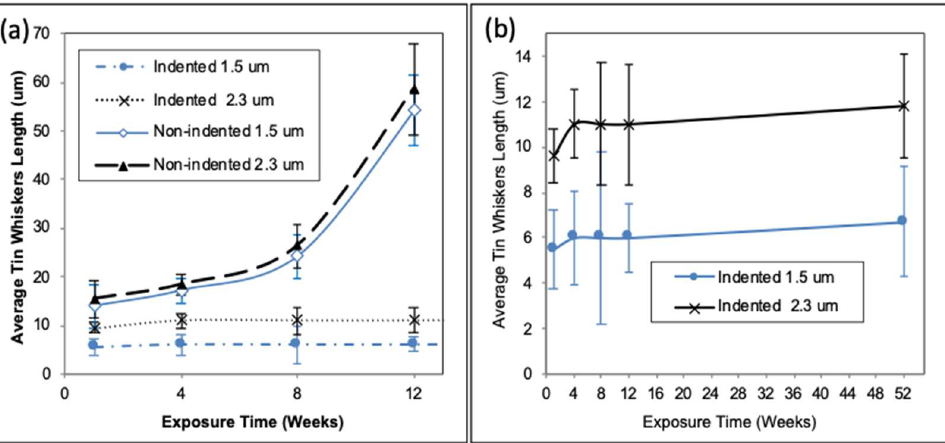
Figure 6. ( a ) The average tin whisker length versus storage times for non-indented and indented surfaces after being stored up to 12 weeks. ( b ) The tin whiskers’ length at the indentation points over storage time up to 52